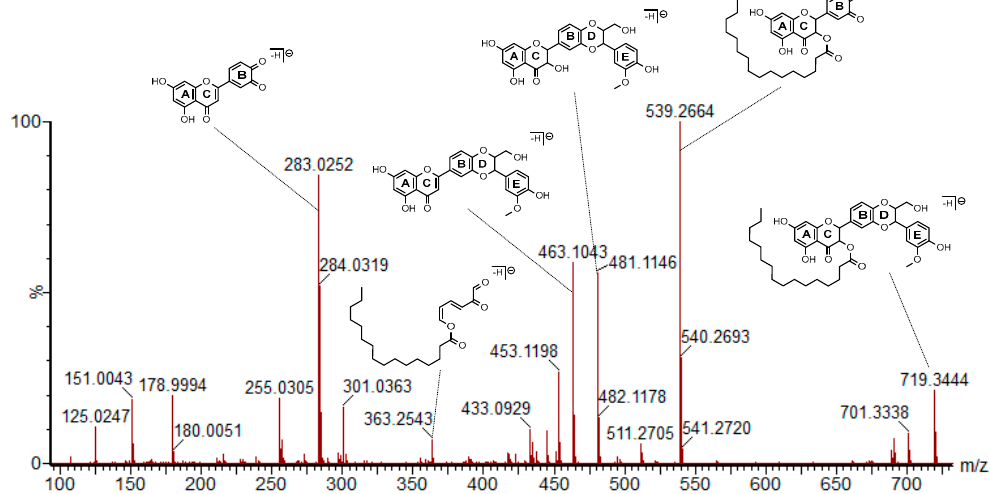
Figure 2. Electrospray ionization with high-resolution mass spectrometry (ESI-HRMS/MS) spectrum of the [M-H] − precursor ion at m / z 719 corresponding to 2 recorded at 33 eV with hypothetic structures for the main fragments.